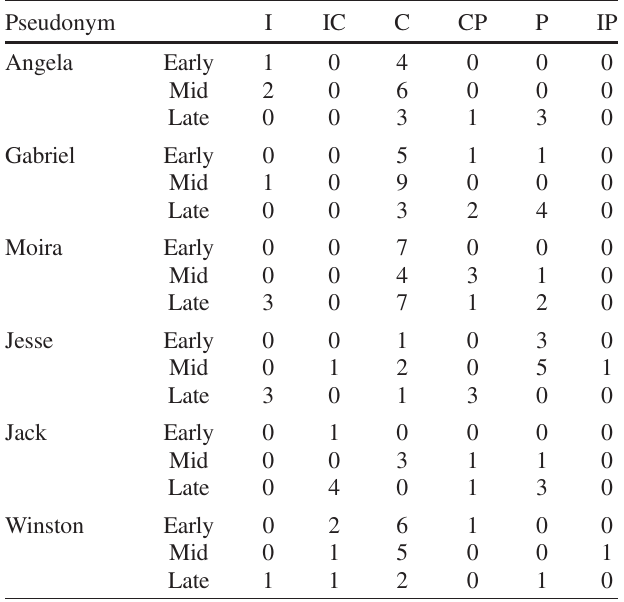
TABLE III. Modal consistency of UEs throughout their early-, mid-, and late-semester observations. As mentioned, there is no singular trend that all UEs follow throughout the